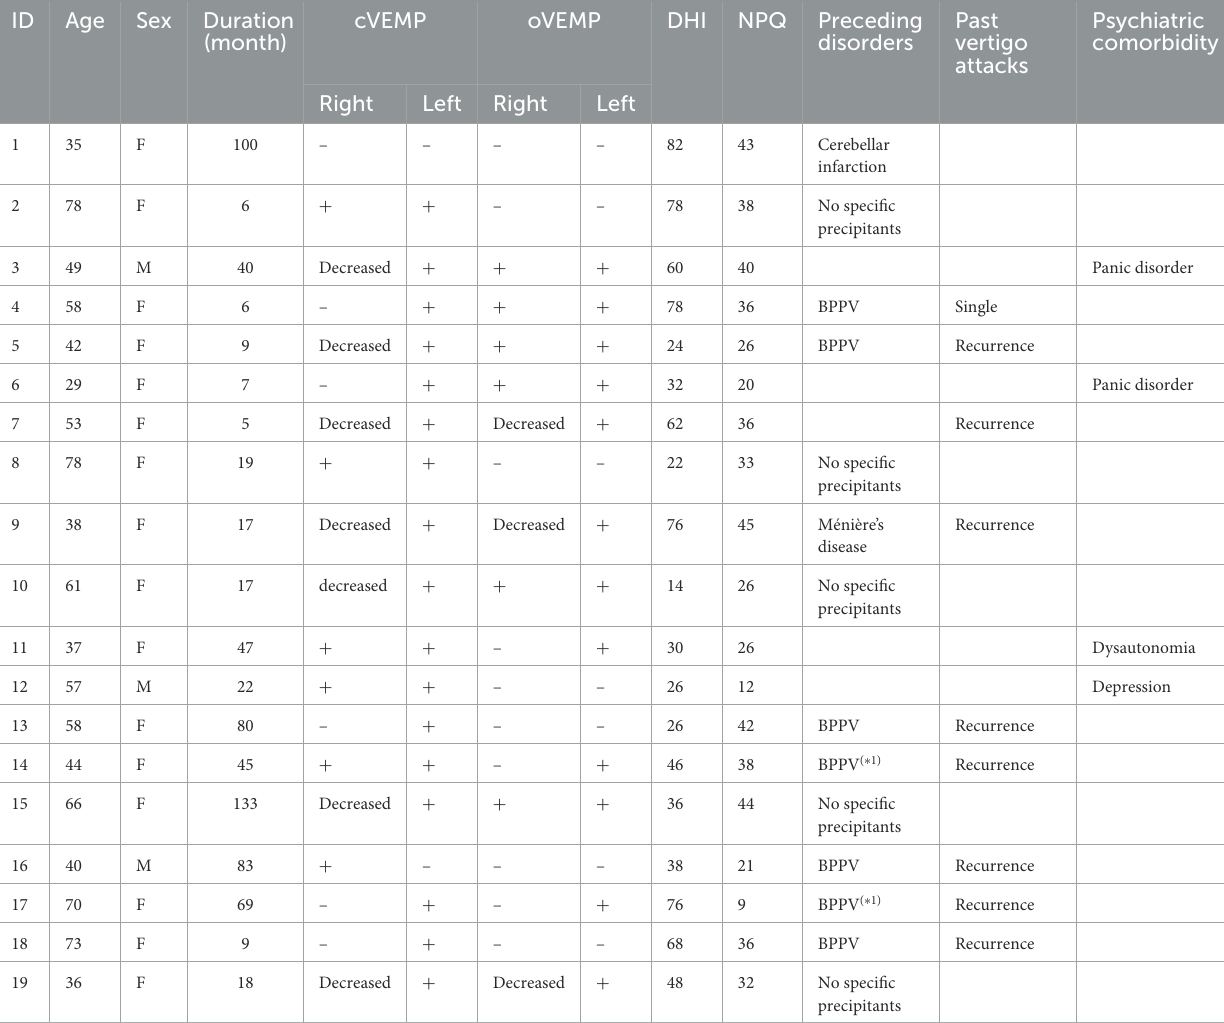
TABLE 3 Clinical characteristics of patients with isolated otolith